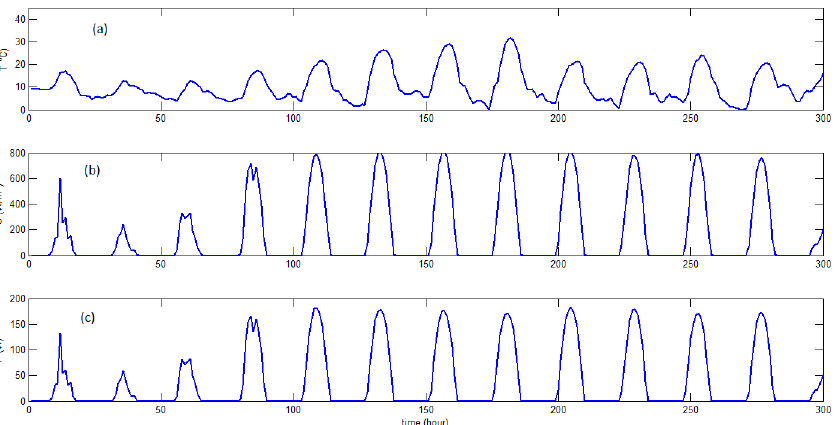
Figure 1. Measured data for 11 days: ( a ) PV output power, ( b ) air temperature, and ( c ) solar irradiance. The second dataset contains measured current-voltage (I–V) curves (1500 samples).